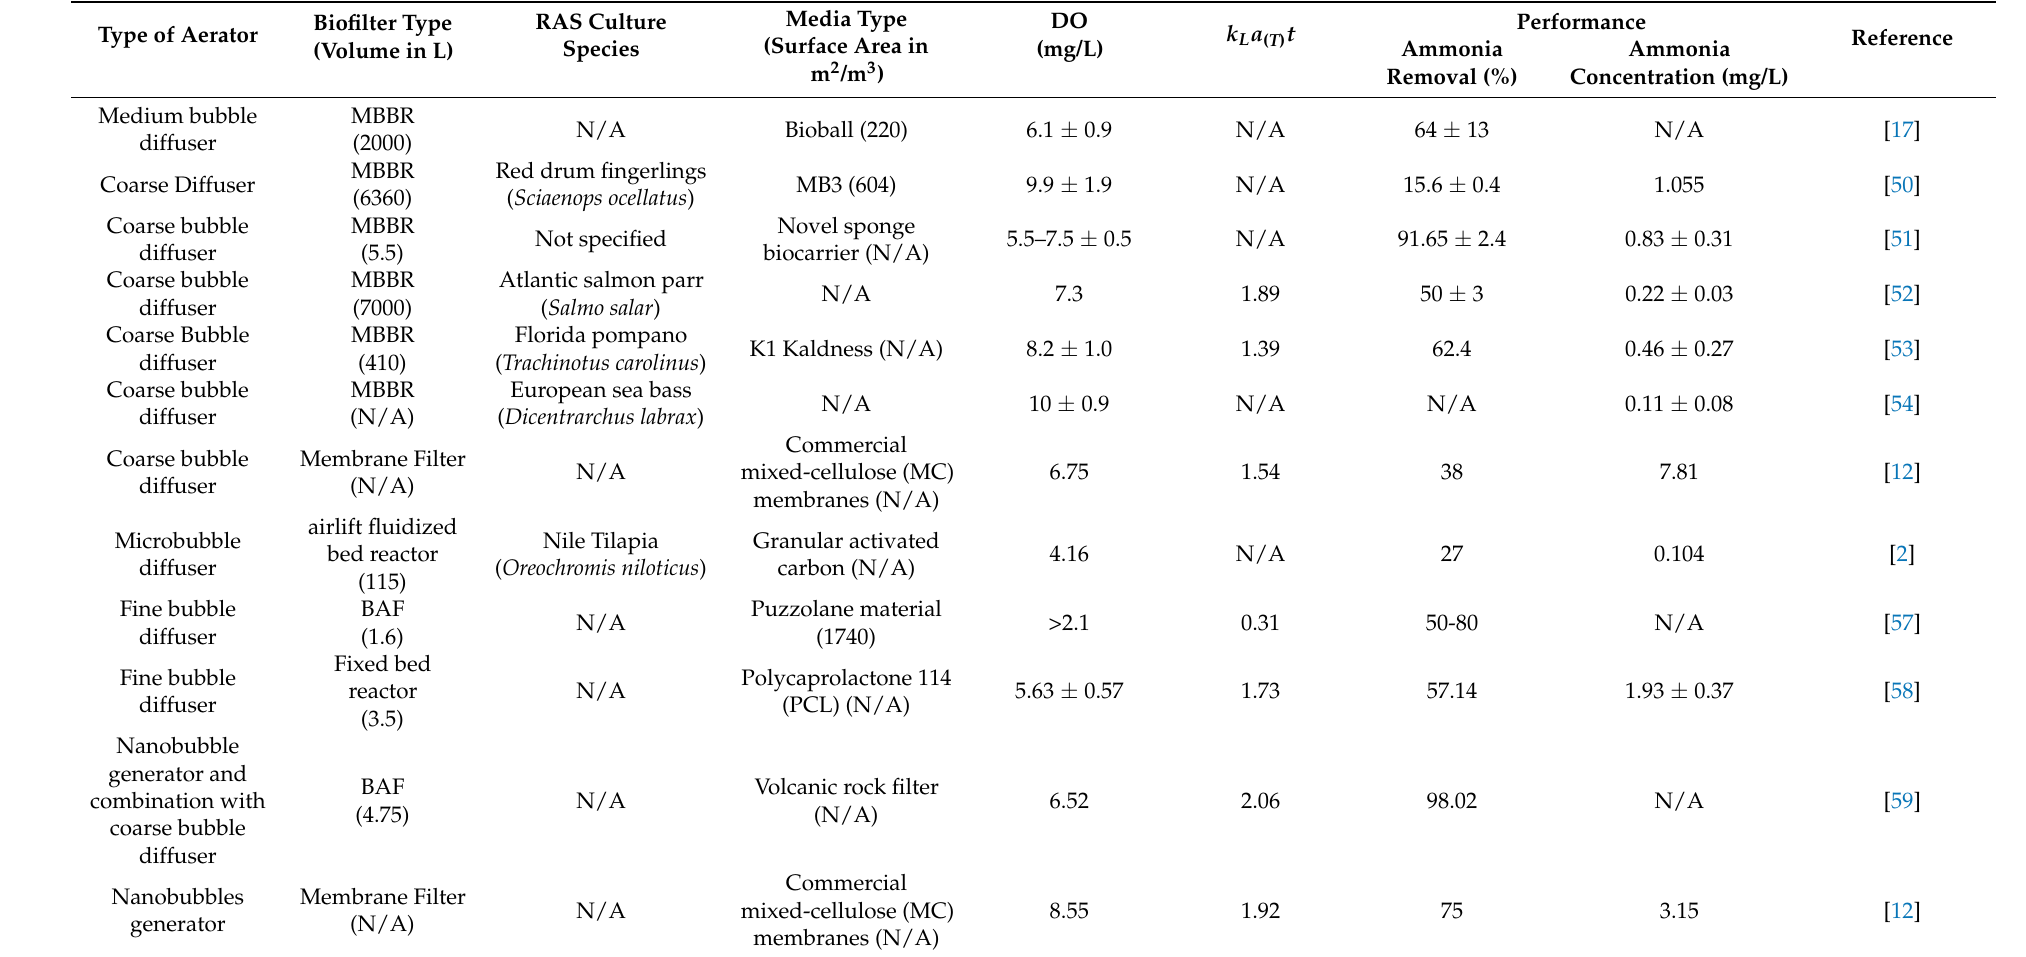
Table 2. Summary of biofilter performance at various types of aerator and biofilter types in